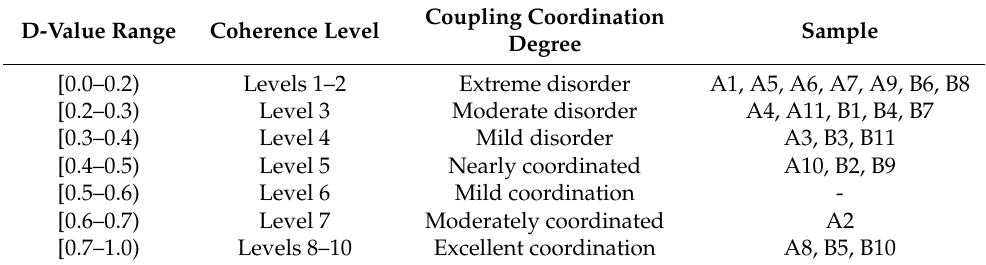
Table 4. Coupling coordination